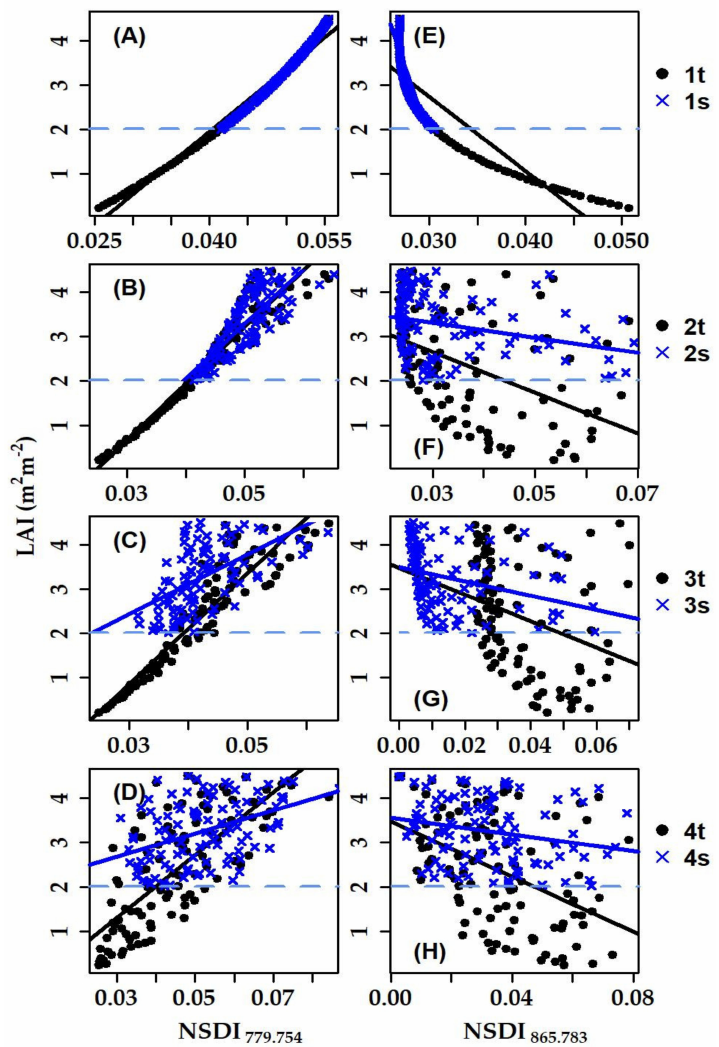
Figure 12. Relationships between NIR-shoulder indices and LAI for all eight scenarios for both temporal (( A , E ) 1t; ( B , F ) 2t; ( C , G ) 3t; and ( D , H ) 4t) and spatial scale observations (( A , E ) 1s; ( B , F ) 2s; ( C , G ) 3s; and ( D , H ) 4s). The horizontal dashed line represents the minimum value of LAI when PROSAIL was run using spatial observation LAI ranges as input parameter. In all panels, solid lines represent a linear fit to the